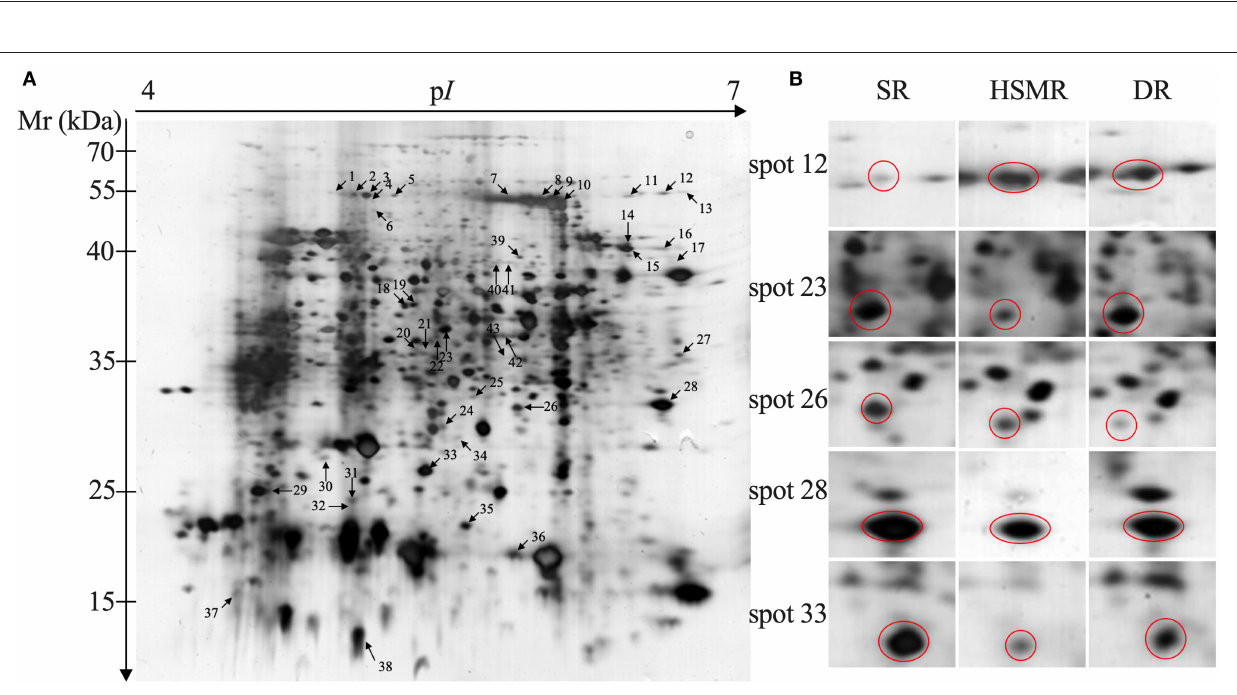
FIGURE 4 | Two-dimensional electrophoresis analysis of protein extracted from three different ecotypes of reed. The numbers assigned to the spots correspond to those listed in Table 1 . (A) Representative gel of total protein extracted from swamp reed (SR); (B) the enlarged windows of the representative spots with variation in protein abundance from three different ecotypes of